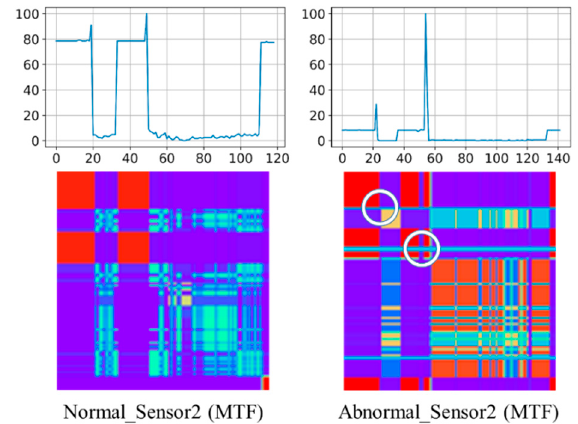
Figure 2. A Markov Transition Field (MTF) example of normal sensor and abnormal sensor in a Wafer dataset.